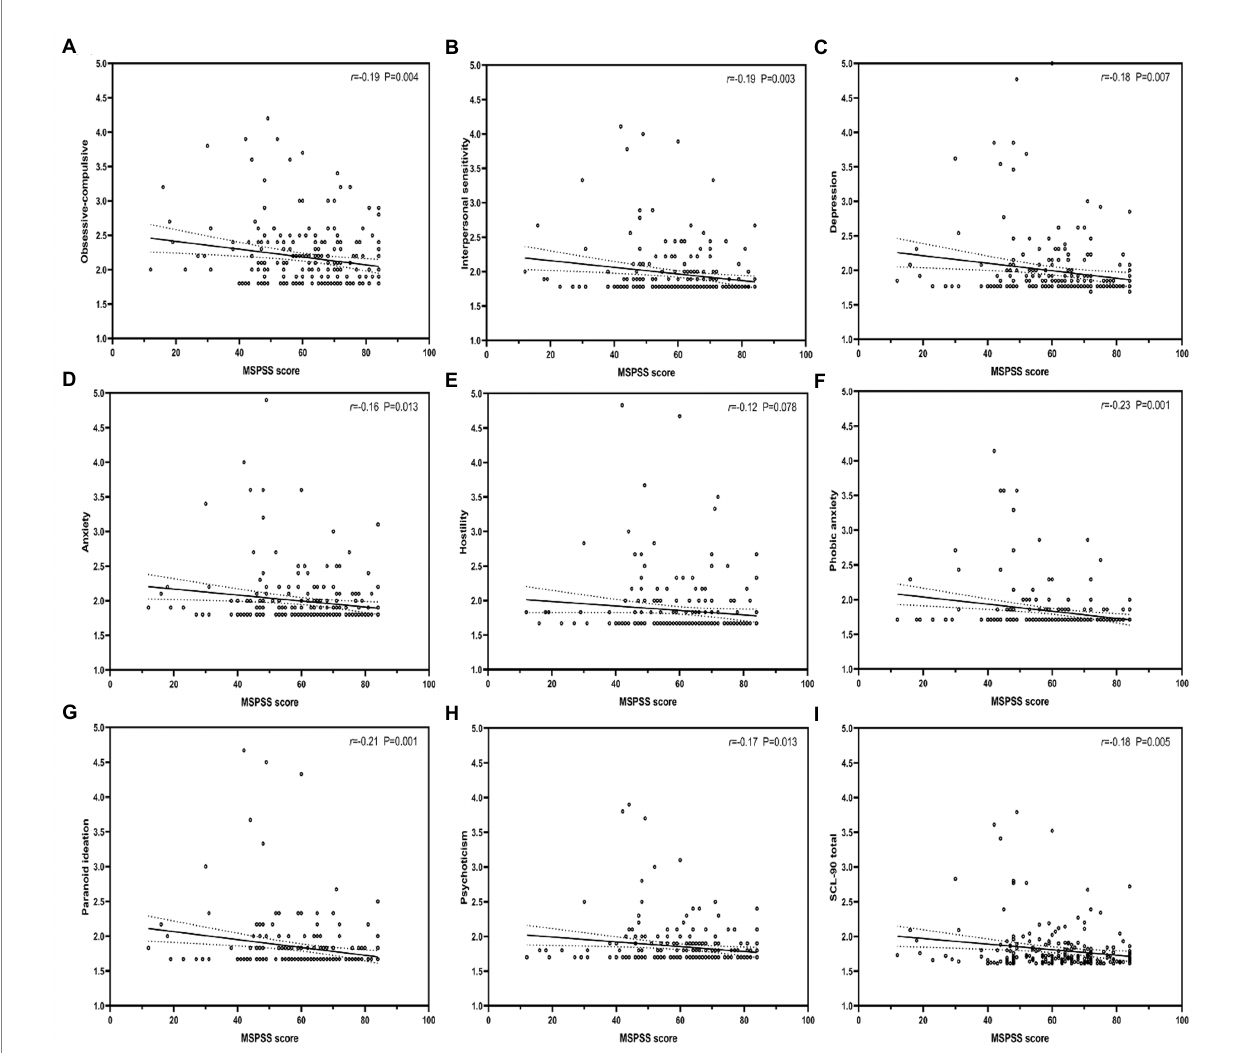
FIGURE 2 Correlation between perceived social support, and each dimension of SCL-90. MSPSS, Multidimensional Scale of Perceived Social Support. r: Pearson correlation coefficient; p: p -value.